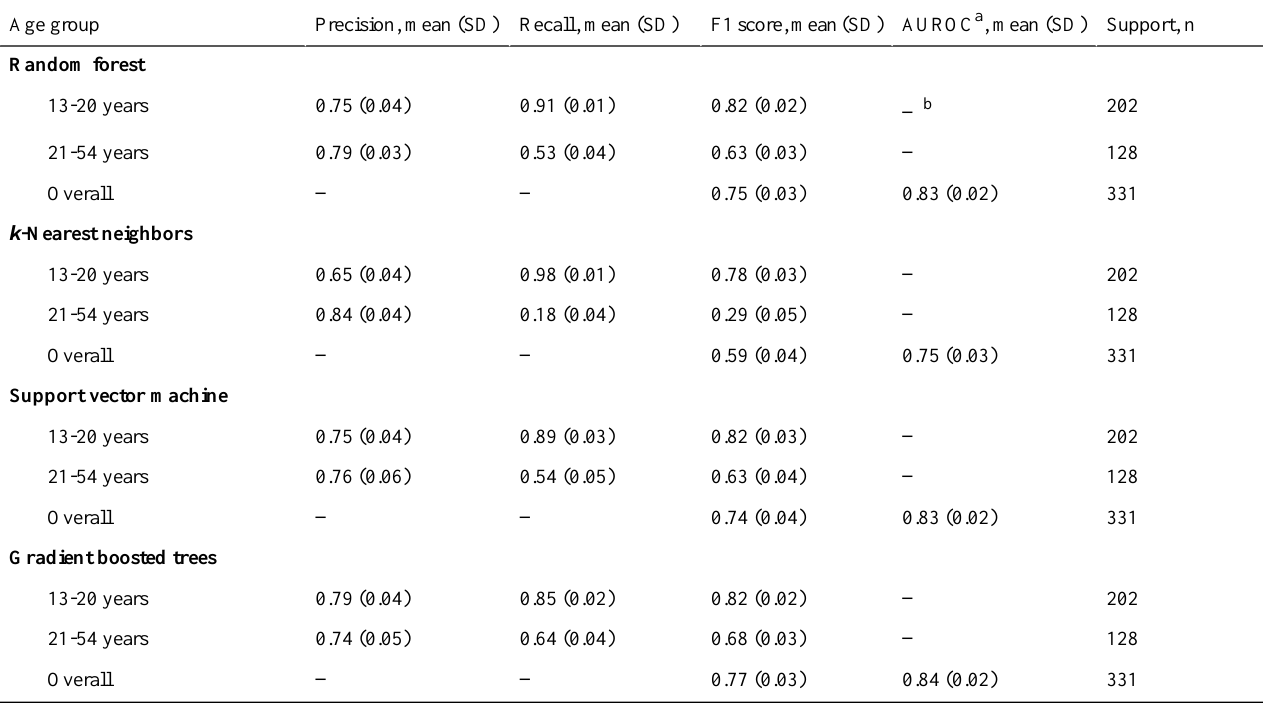
Table 3. Classifier performance for predicting manually labeled age of Reddit users based on the full derived variable set.